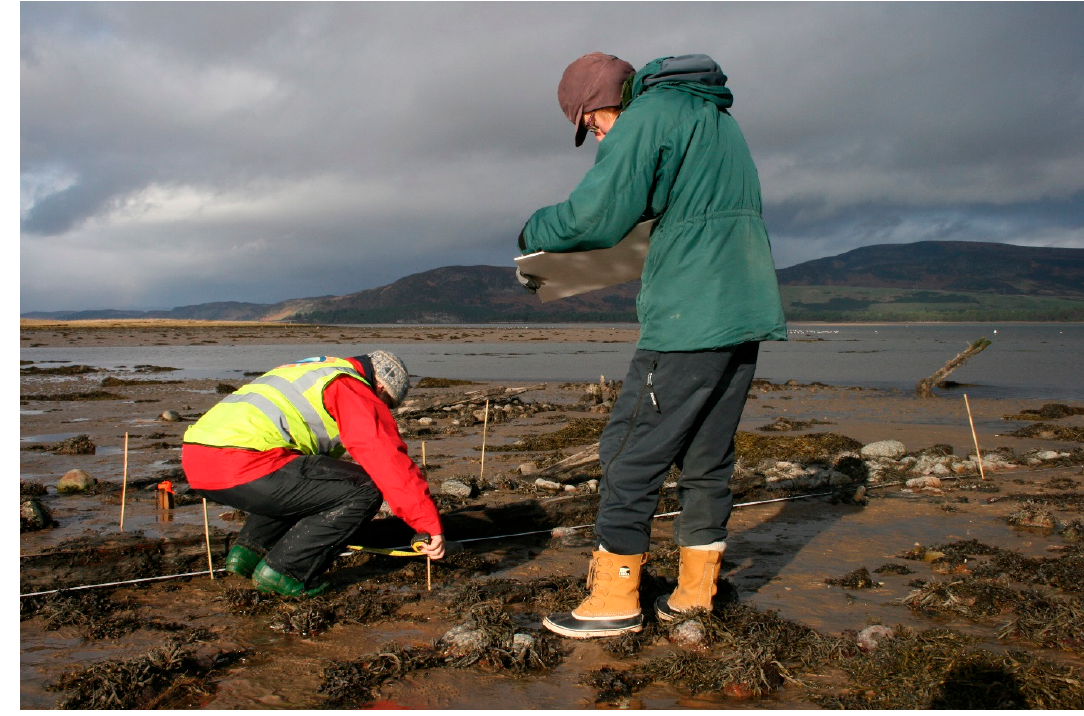
Figure 3. Volunteers recording the remains of a boat, Loch Fleet, February 2014.